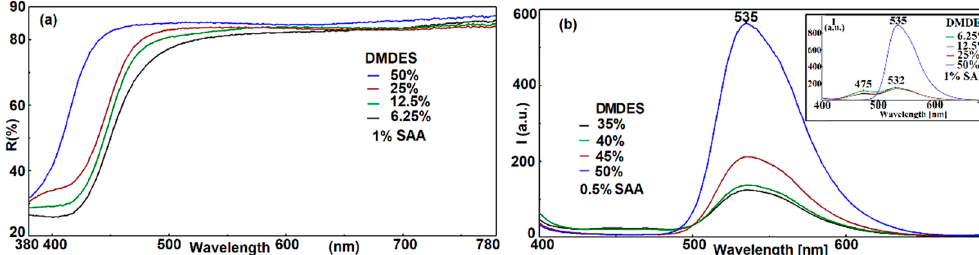
Figure 4. Reflectance ( a ) and fluorescence emission spectra ( b ) of G5 films at different DMDES loadings. (The inset shows the intensity of fluorescence emission at lower DMDES loadings).